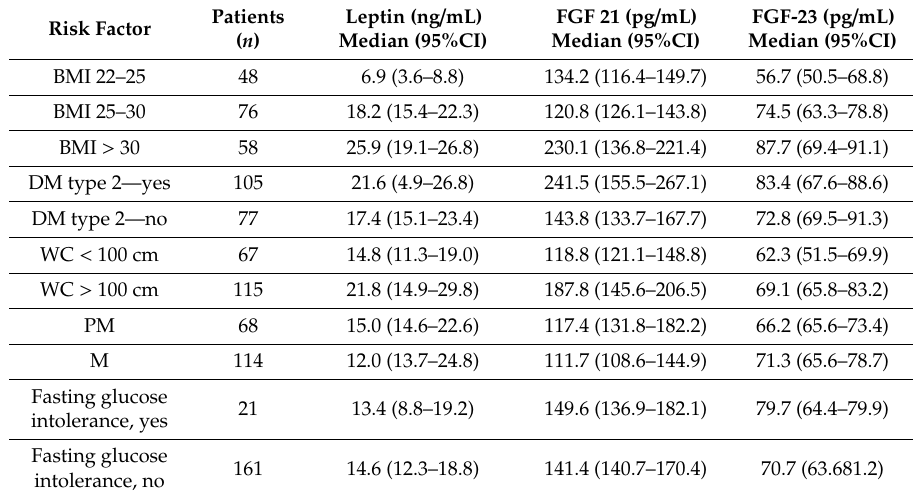
Table 1. Examined protein concentrations in relation to endometrium cancer risk